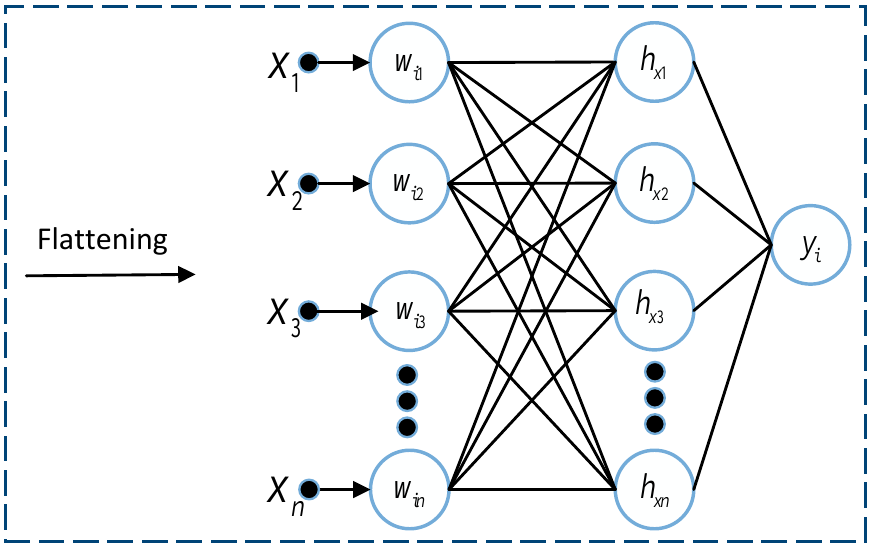
Figure 6. Basic structure of the fully connected